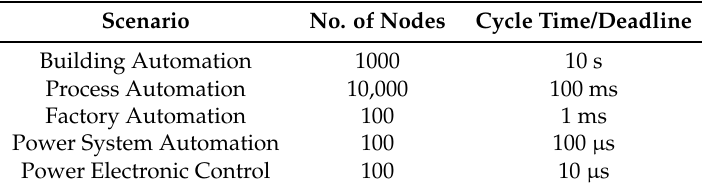
Table 1. Typical requirements of industrial control applications.